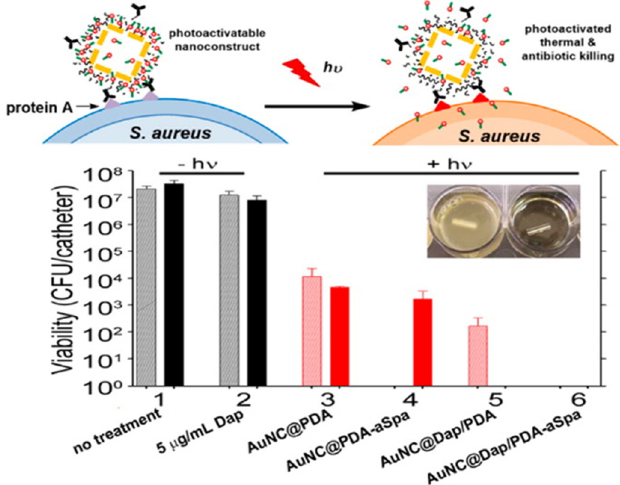
Figure 7. Synergistic effect of laser-induced and controlled release of Dap in S . aureus . Reprinted with permission from Copyright © 2016 American Chemical Society: https://pubs.acs.org/doi/full/ 10.1021/acsinfecdis.5b00117, accessed on 20 May 2021, further permissions related to the material excerpted should be directed to the